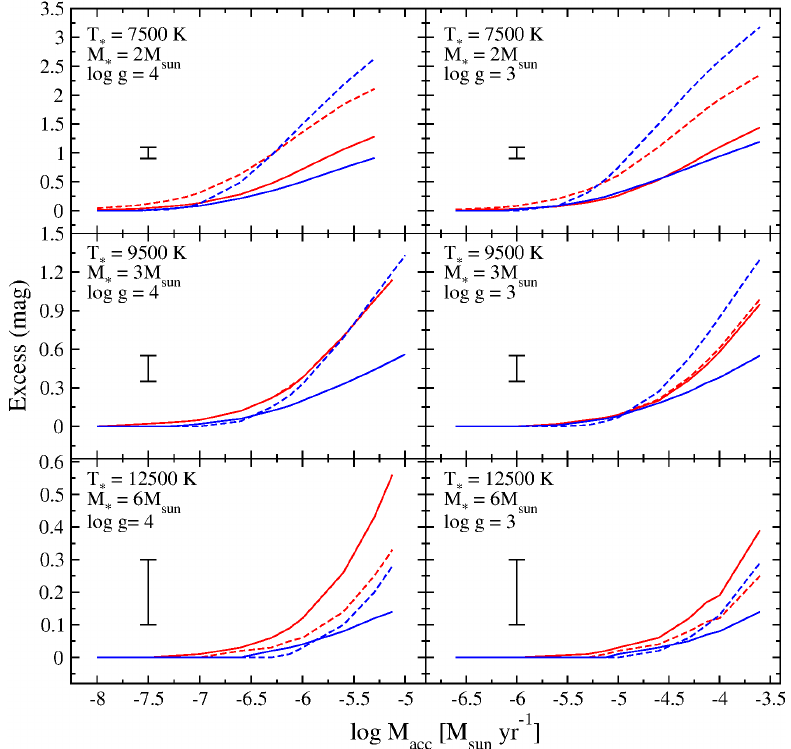
Figure 4. Excess predicted from magnetospheric accretion (red lines) and boundary layer (blue lines) shock modeling as a function of the mass accretion rate. The solid lines refer to the Balmer excesses ( ∆ D B ) and the dashed lines to the UV excesses ( ∆ UV ). The panels show models for a late-type HAe star (top), an early-type HAe star (middle), and a mid-type HBe star (bottom) with the stellar parameters indicated in the legends and surface gravities decreasing from left to right. All models assume F = 10 12 erg s − 1 ; R i = 2.5R ∗ (MA), δ 0 = 0.03, vsin i = 100 km s − 1 , and i = 45 ◦ (BL). Maximum observational errorbars corresponding to excesses based on broadband photometry are